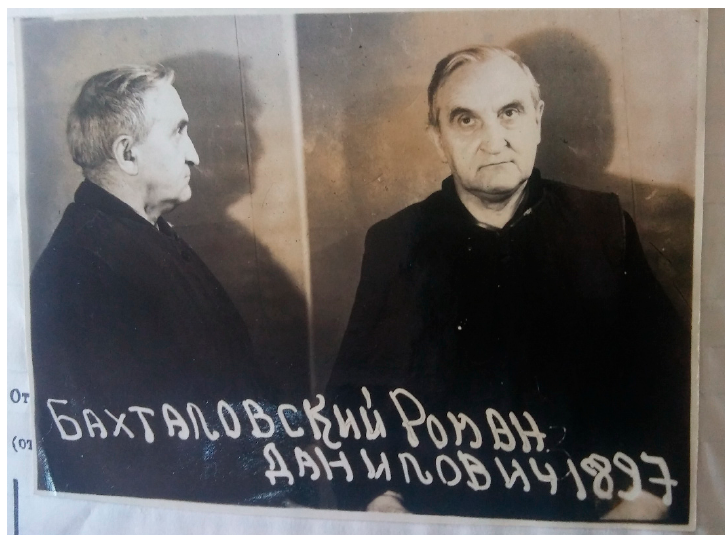
Figure A1. The picture of Fr. Roman Bakhtalovskyy in his criminal case.